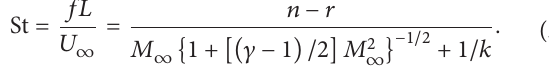
(based on the boundary layer thickness) Re 𝑏 ranging